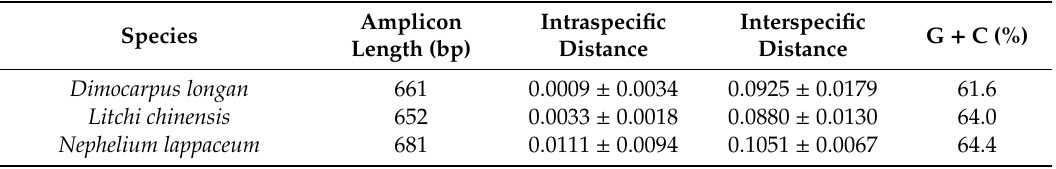
Table 1. Summary statistics for ITS